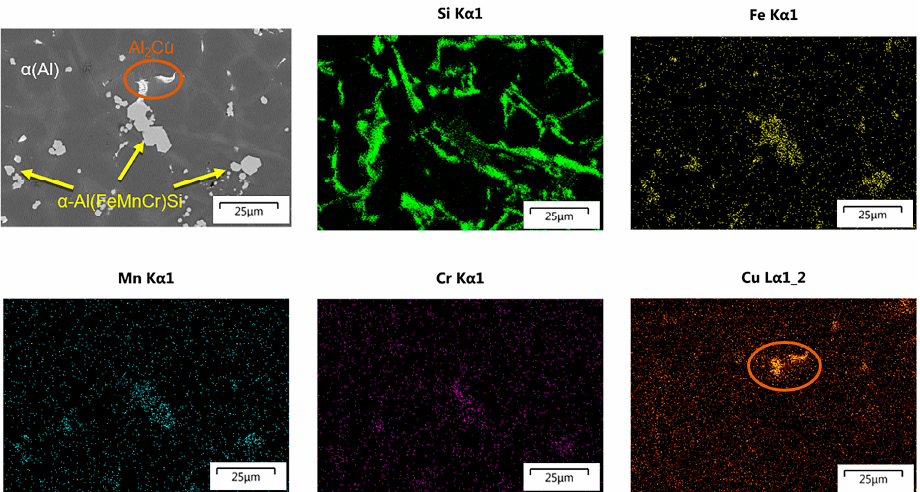
Figure 13. EDS analysis of Fe inter-metallic phase.